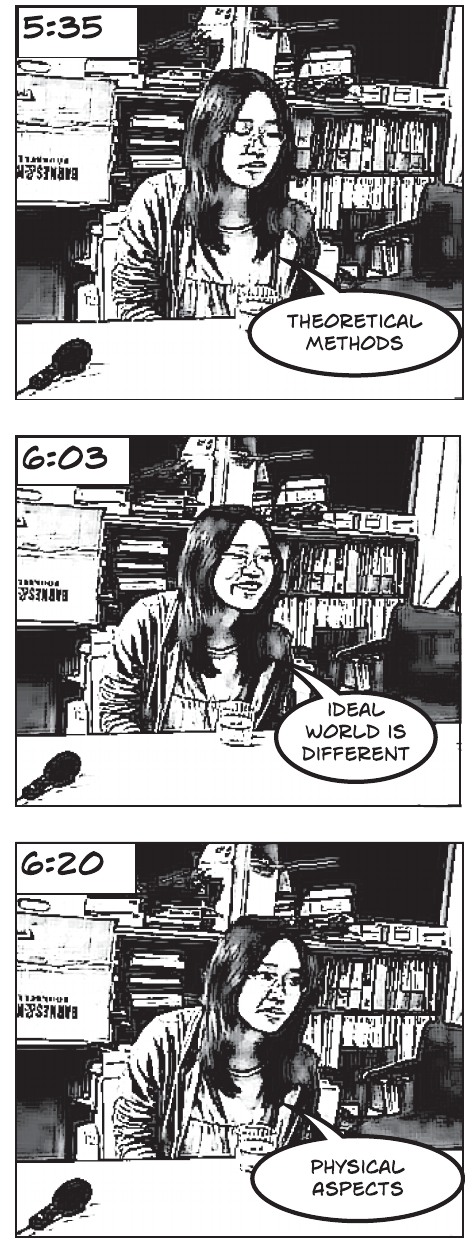
FIG. 1. The panels show Judy ’ s facial expressions in episode 1. The first and third panel depict her negative emotions in facial expressions as she talks about theoretical methods and physical aspects. The second panel shows contrasting facial expressions during this